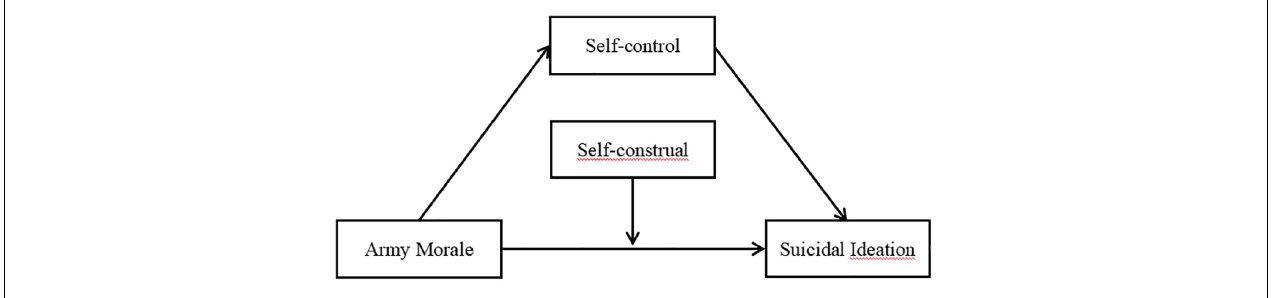
FIGURE 1 | Theoretical moderated mediation model.